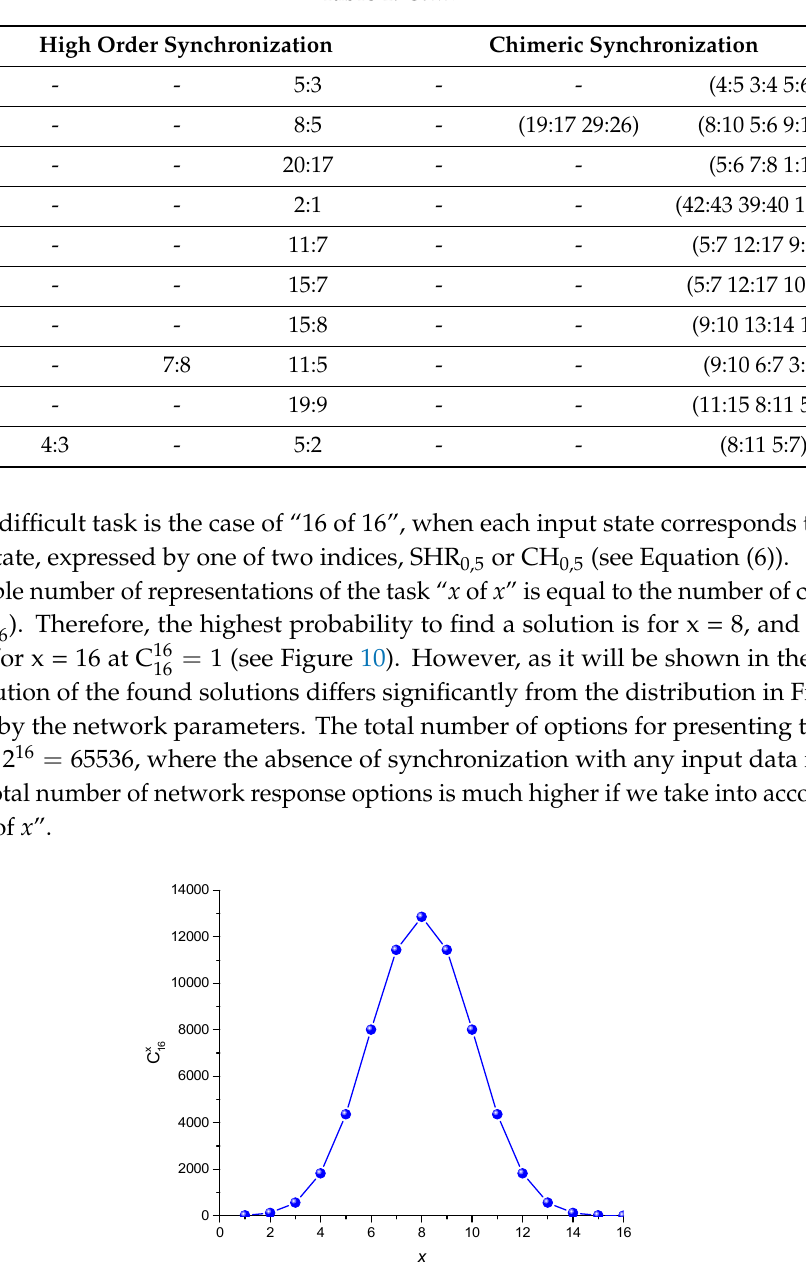
Figure 10. Histogram of the number of “ x of x ” task representations.